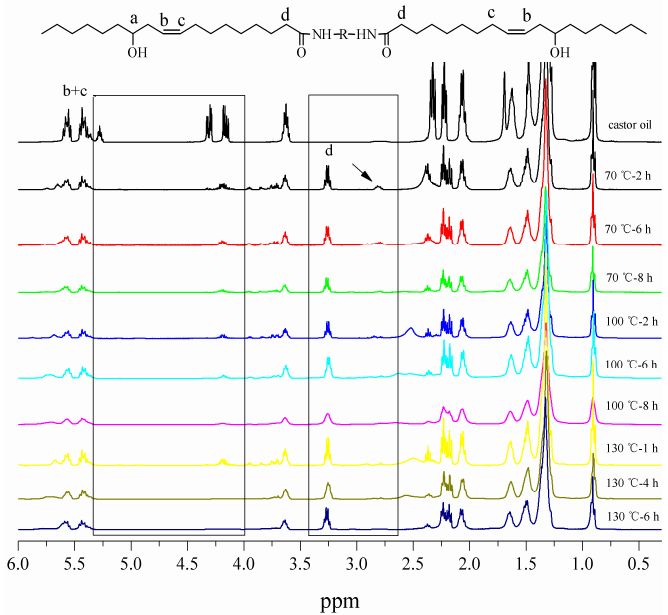
Figure 1. 1 H ‐ NMR spectra of castor oil and amide diol monomers synthesized from hexamethanylenediamine (HDA).